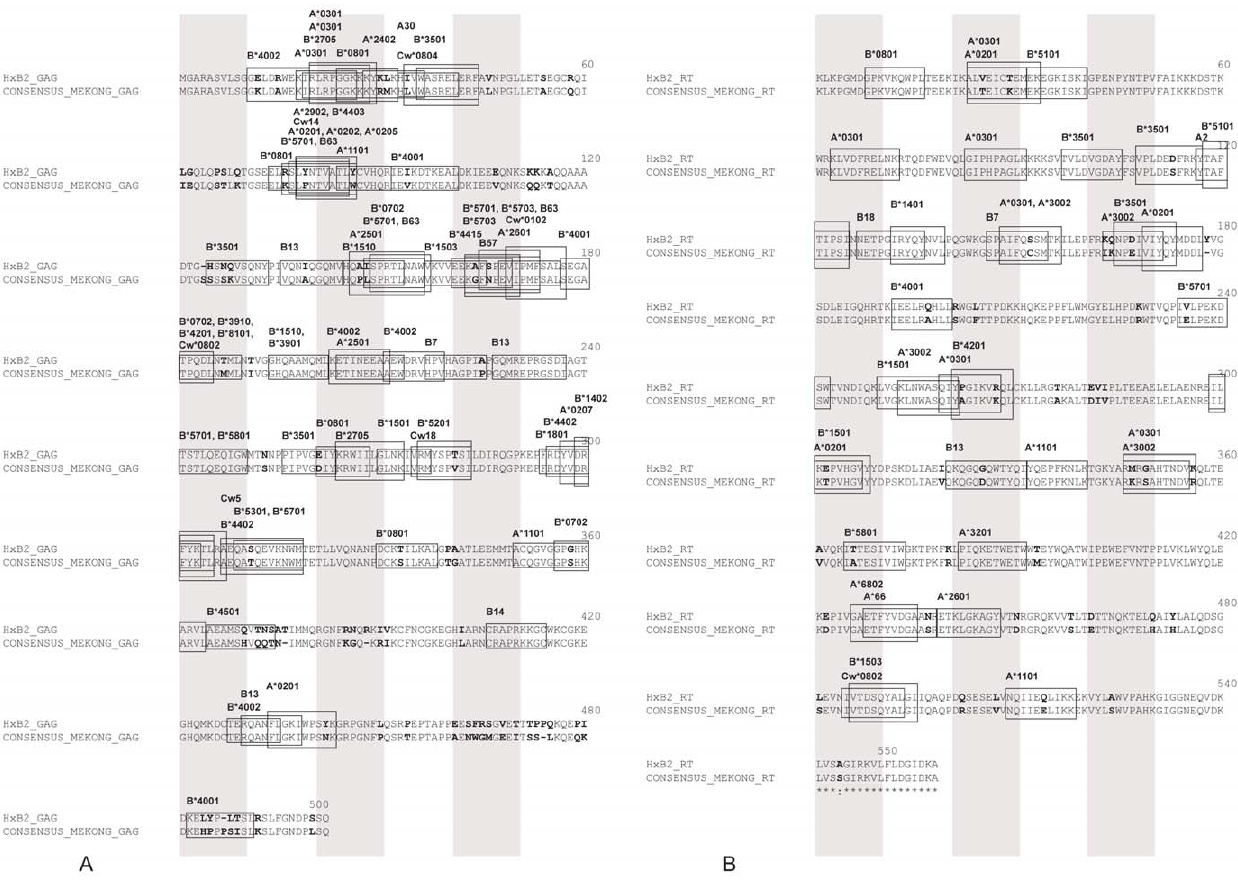
Figure 3. Comparison of Gag (A) and RT (B) Vietnamese consensus sequences with HxB2 strains. Optimal CTL epitopes are highlighted by boxes. HLA restriction is indicated on the corresponding epitopes. Amino acid substitutions are indicated in bold. Shaded vertical bars separate blocks of 10 amino acids.